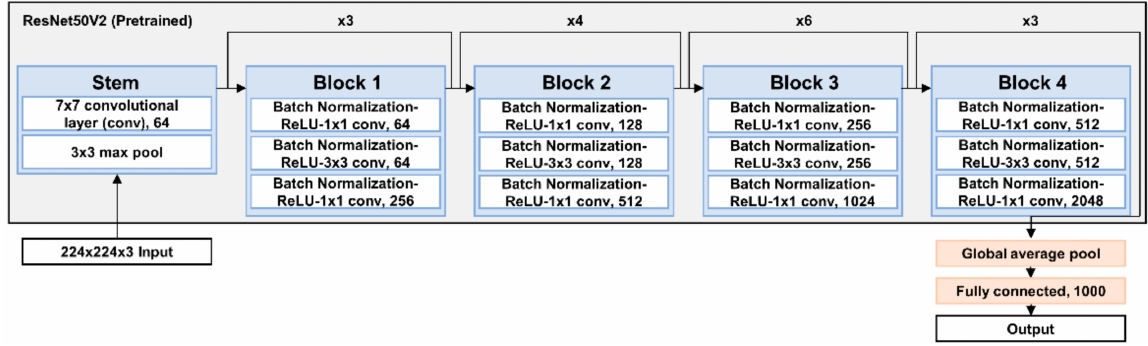
Figure 5. CNN architecture of ResNet50V2, which was used as backbone model of presented